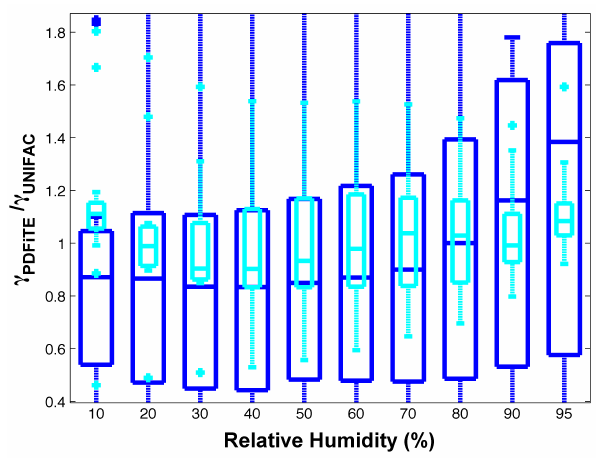
Fig. 5. Ratio of activity coefficients predicted by PD-FiTE to UNIFAC as a function of RH. Blue boxes correspond to PD-FiTE binary and cyan to PD-FiTE ternary. Using the MATLAB R2008a software package, the box represents the upper/lower quartile range with the median highlighted inbetween. The whiskers represent values within the 10 and 90 percentile boundaries, outliers representing any values greater than 1.5 times the inter-quartile range.